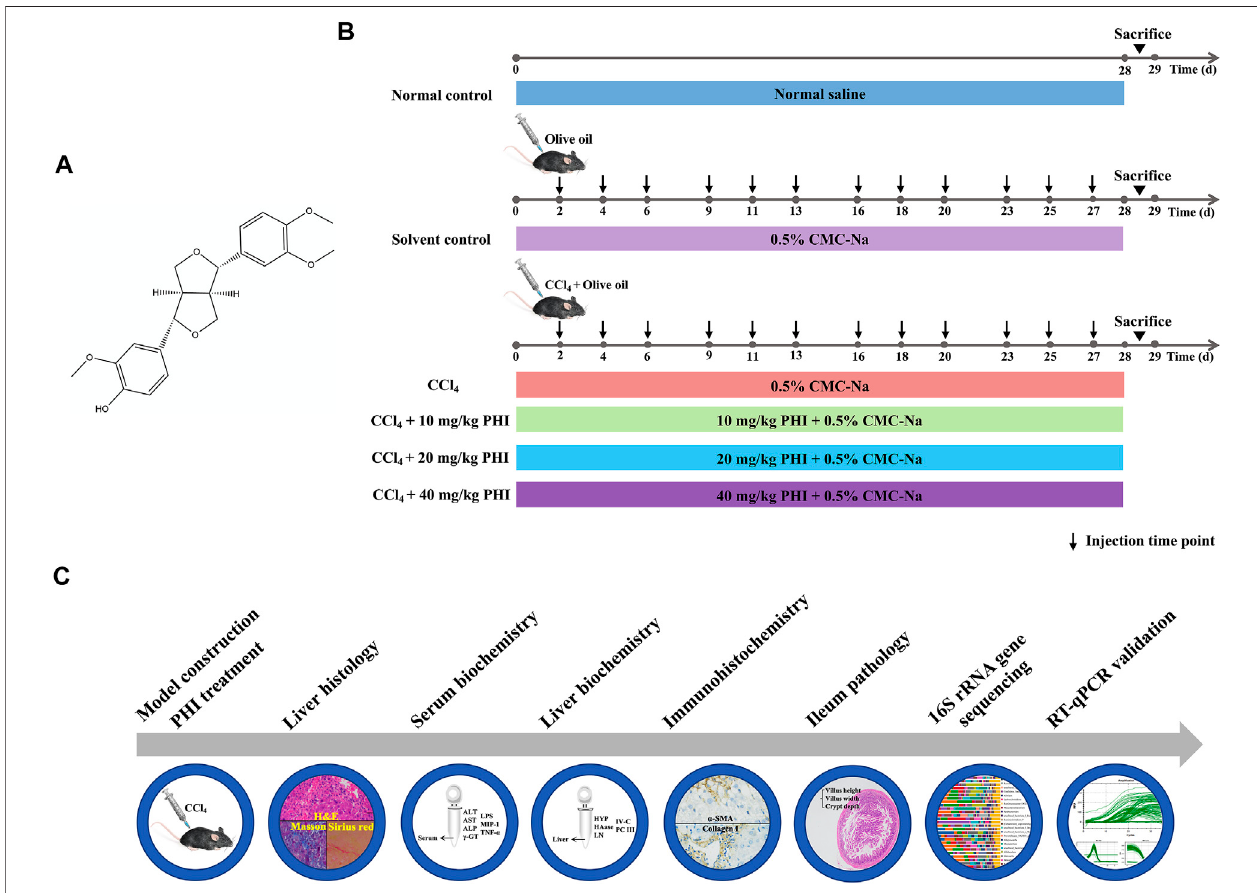
FIGURE 1| Experimental outline. (A) Chemical structure of PHI. (B) Flow diagram depicting the treatment ofmice in all groups. (C) Description of the experimental design.